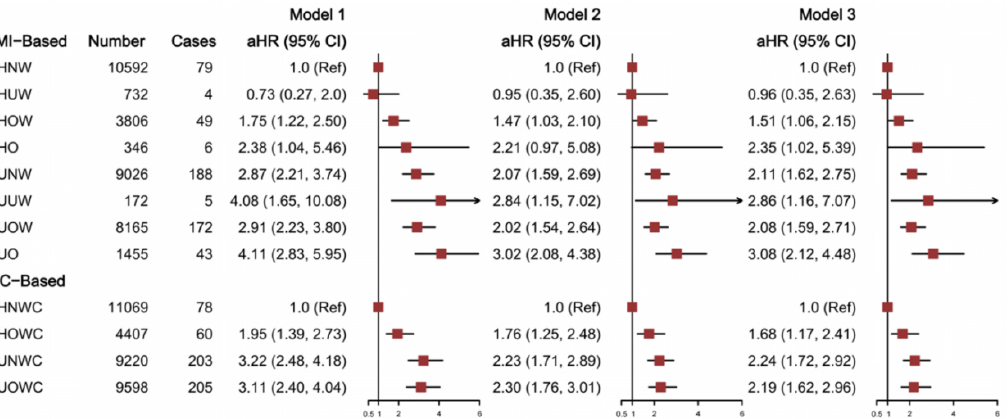
Figure 1. Hazard ratios for stroke according to metabolic phenotypes with an alternative definition. Model 1, unadjusted. Model 2, adjusted for gender and age. Model 3, adjusted for gender, age, education degree, marital status, retirement, place of residence, smoking index, alcohol drinking, physical activities, and consumption of fruit, vegetables, fish, and processed and unprocessed meats. BMI was additionally adjusted in the WC-based metabolic phenotypes in Model